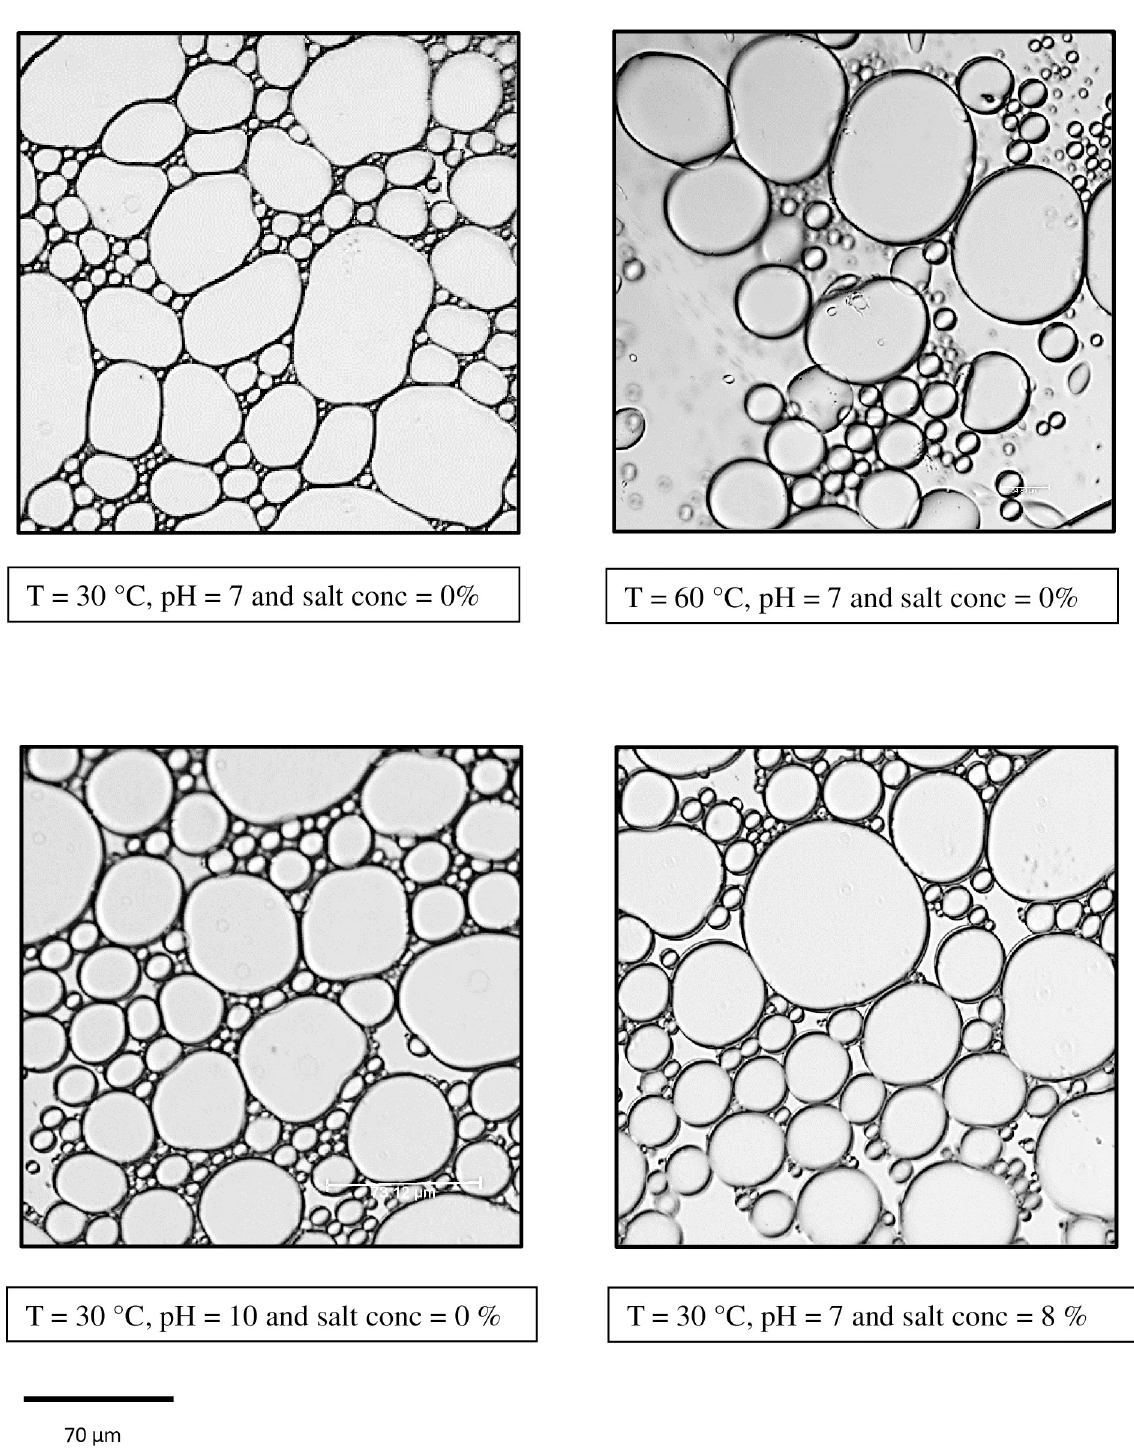
Fig 3. Effect of temperature, pH and salt concentration on the microstructure of emulsion.